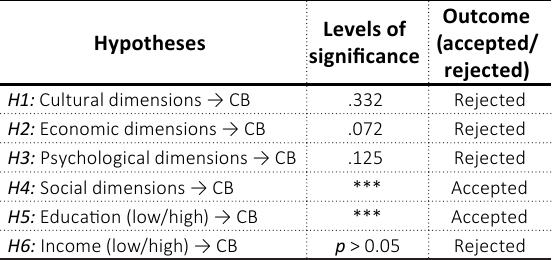
Table 7. Results of hypotheses testing